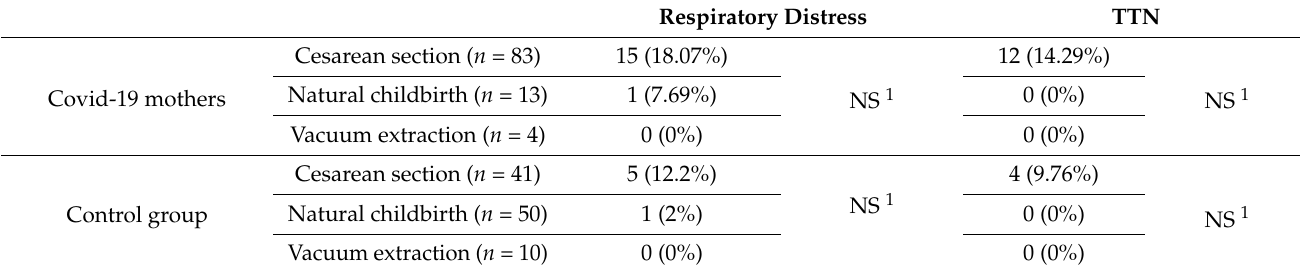
Table 4. Association between the mode of delivery and respiratory distress in the study group and control group.